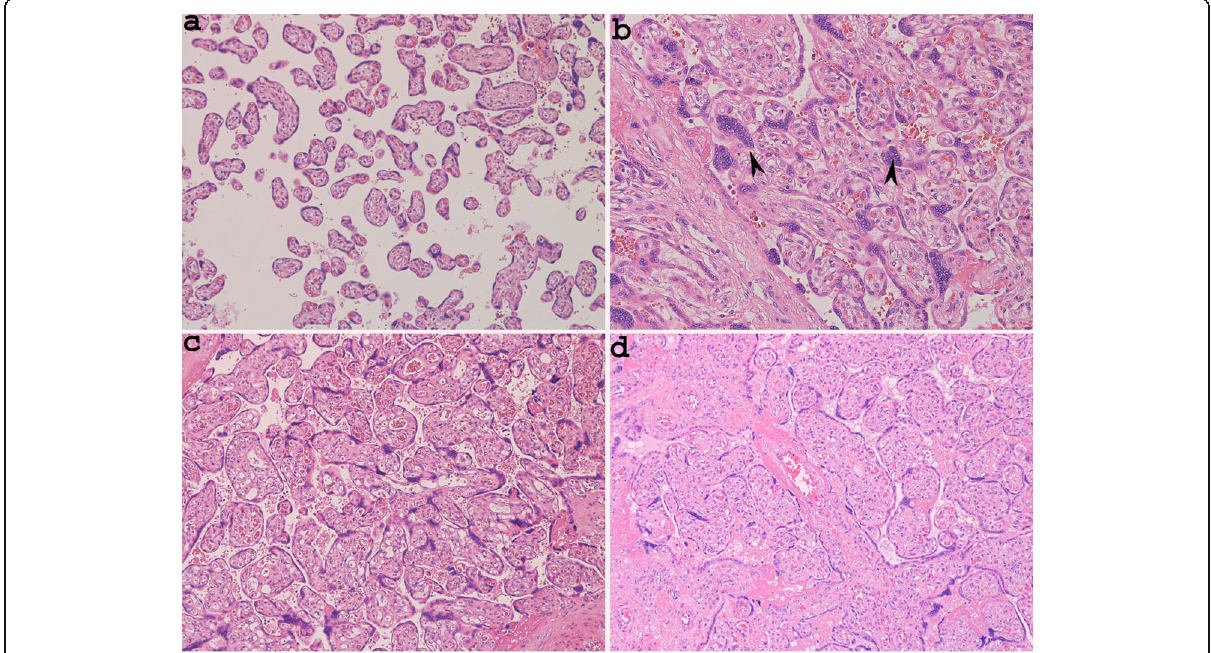
Fig. 2 Distal villous hypoplasia with elongated and slender distal villi and wide intervillous spaces ( a Case 3, haematoxylin and eosin stain × 100) and Tenney-Parker change, with villi showing an increased number of syncytial knots ( b Case 3, haematoxylin and eosin stain × 100, arrowheads: syncytial knots). Chorangiosis with terminal villi containing numerous capillaries ( c Case 2, haematoxylin and eosin stain, × 100); delayed